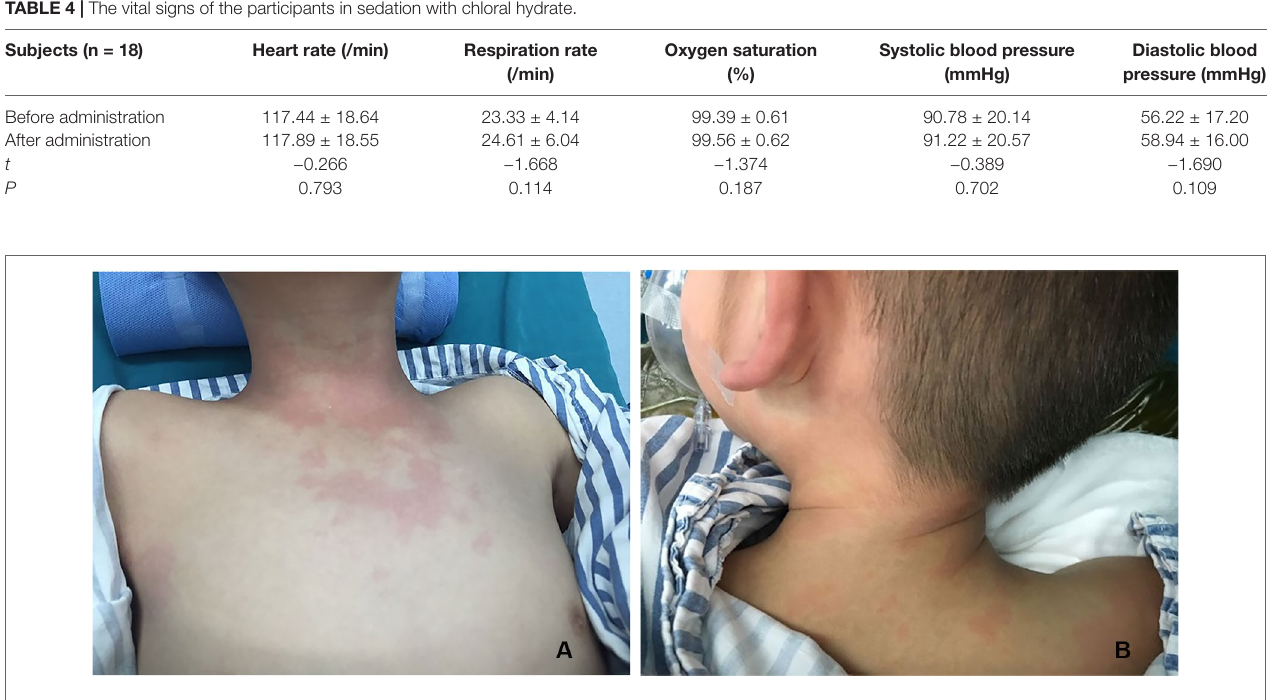
FIgURE 1 | Rash in chest (A) and neck (B) after administration of contrast agent.